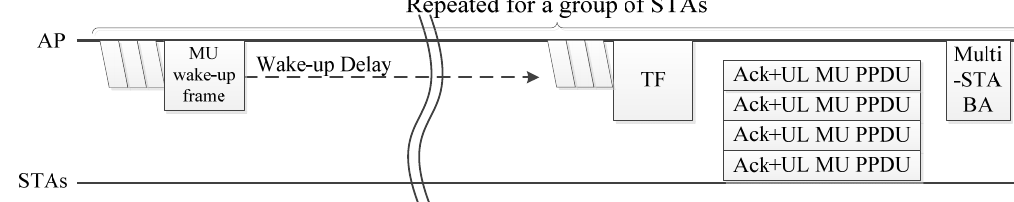
Figure 9. Normal uplink multiuser transmission using wake-up packet for multiple user.